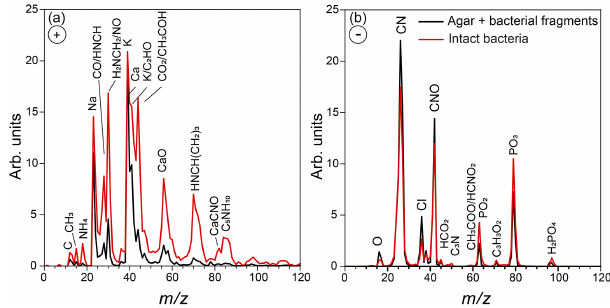
Figure 2. Positive (a) and negative (b) average mass spectra of the particles in the AIDA chamber, measured before Expansion 1. Ref- erence mass spectra of the small size mode, made up of bacterial fragments mixed with agar, which includes particles smaller than 300nm, are marked in black, and the mass spectra of the large size mode particles ( d va >70nm), composed of intact Pseudomonas sy- ringae bacterial cells, are marked in